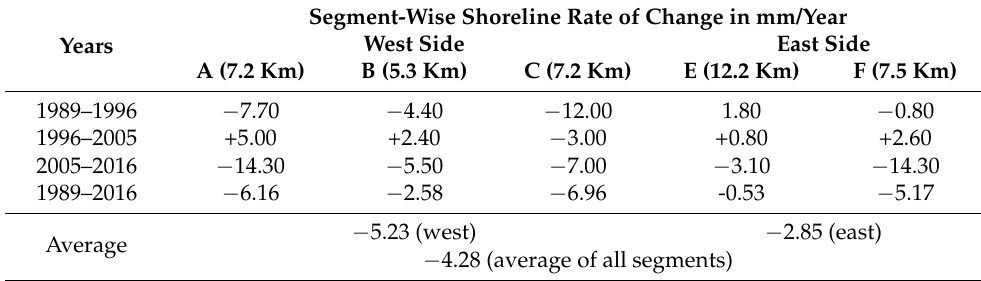
Figure 12. Shoreline change rates around Kutubdia Island for the periods 1989 – 1996 (red), 1996 – 2005 (green), and 2005 – 2016 (blue). Negative values indicate erosion. Table 4. Rates of shoreline change along the different segments of Kutubdia Island for the study period of 1989 – 2016.